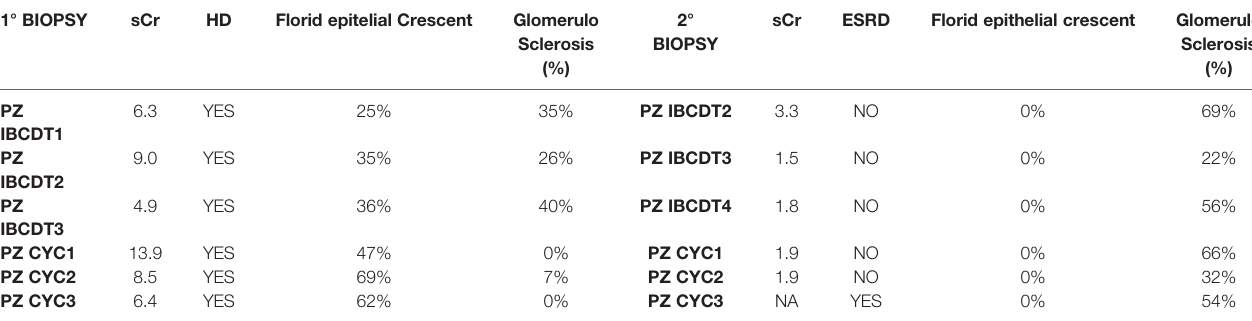
TABLE 4 | Findings of repeated renal biopsy performed during clinical remission in the two groups.